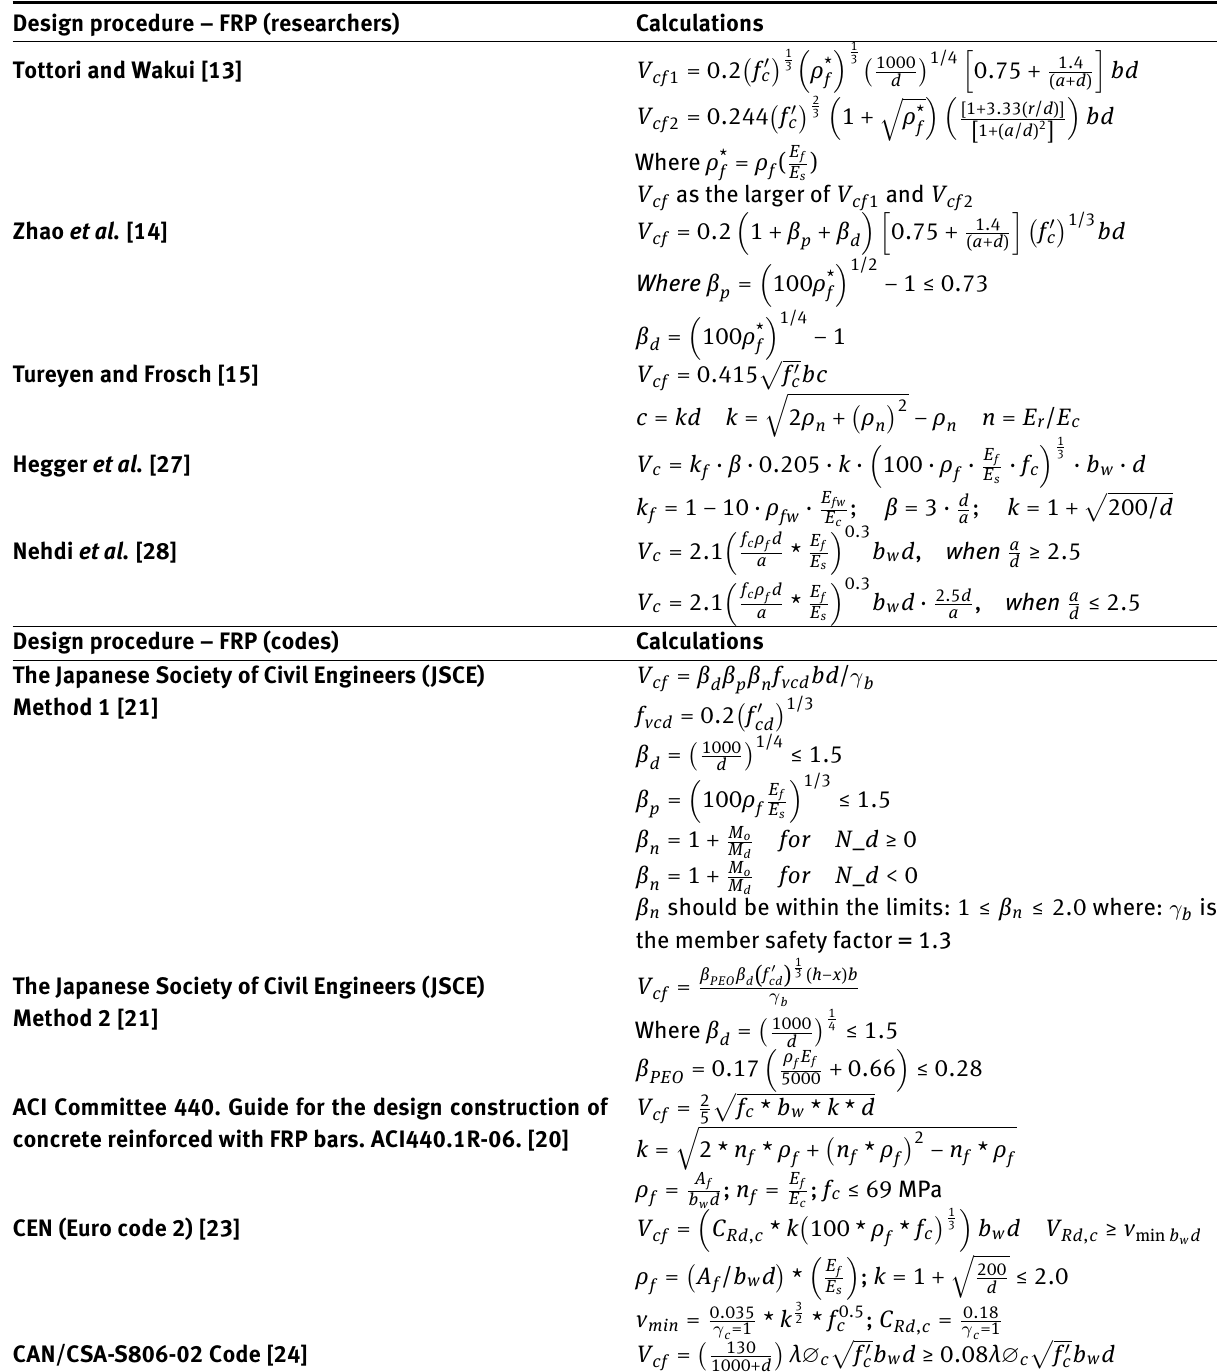
Table 6: Shear capacity of concrete beams reinforced with FRP bars without shear